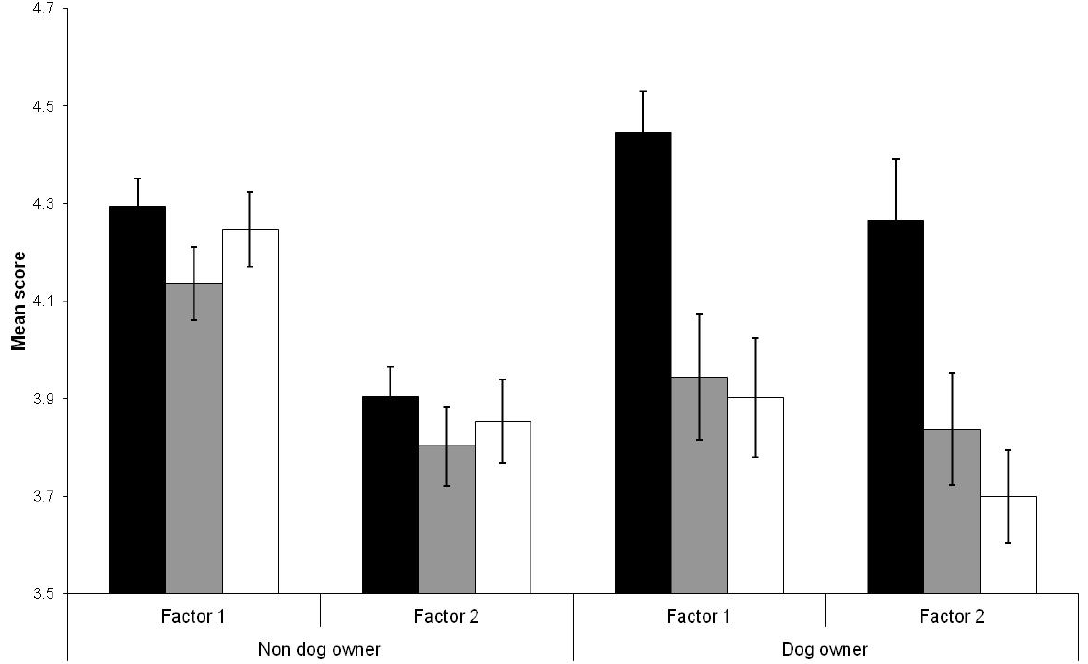
Figure 2. Mean scores (± one standard error) for factors for human-related impacts (Factor 1) and integrity of habitat (Factor 2) in relation to respondents beach use (black bars represent yearly, grey bars monthly, and white bars weekly) and dog walking on beaches (dog owners, non-dog owners).